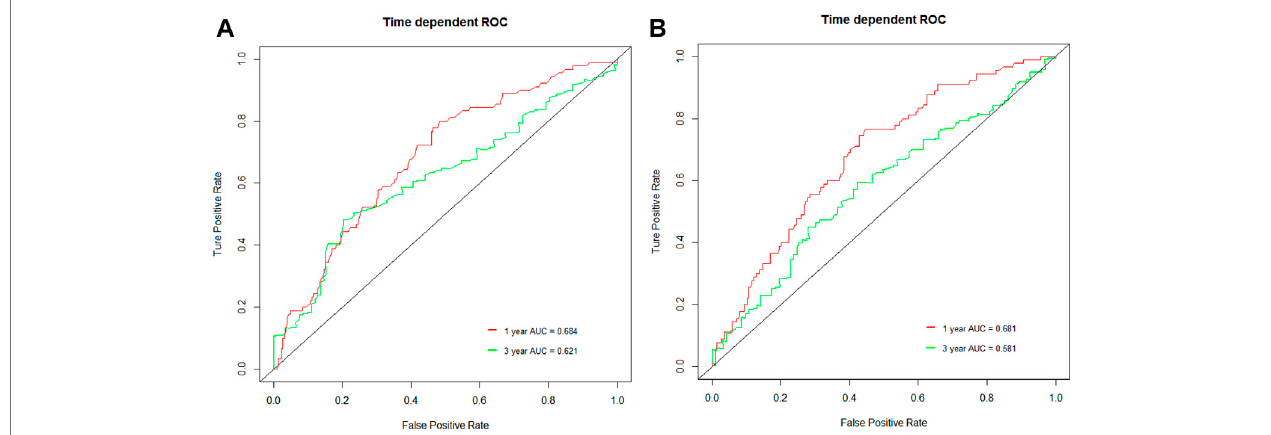
FIGURE 3 | ROC curves of the NLR and PLR in unresectable HCC patients. (A) 1-year and 3-year ROC curve of NLR; (B) 1-year and 3-year ROC curve of PLR.